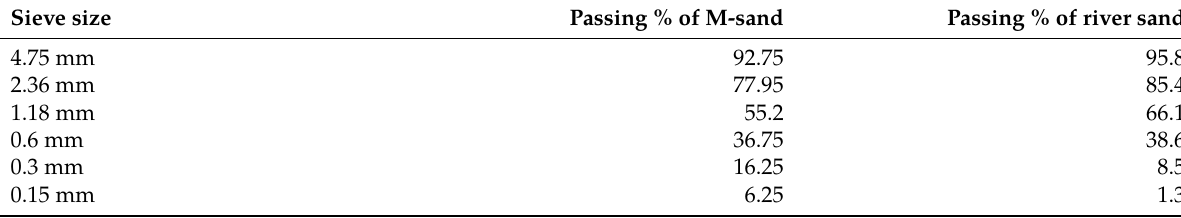
Table 4: Sieve analysis of two sands.